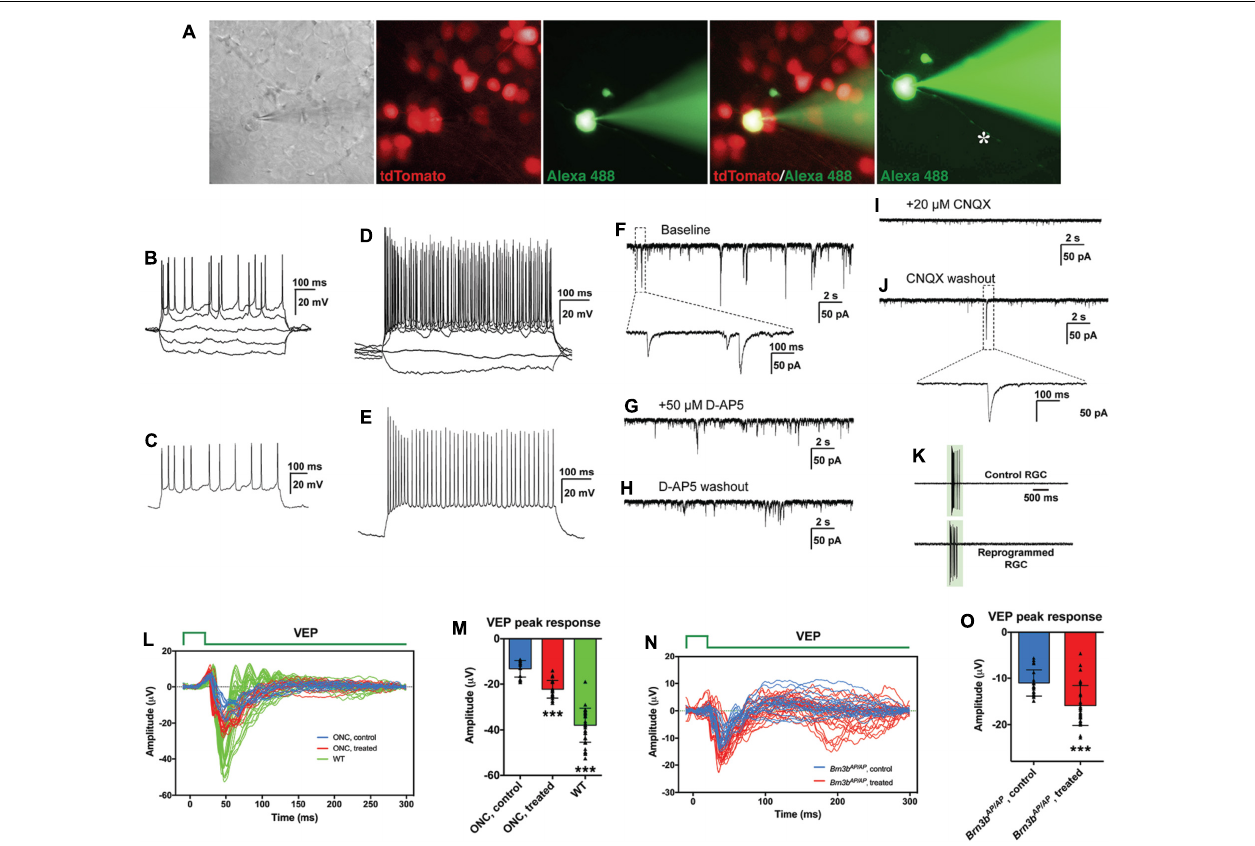
FIGURE 7 | MG-derived RGCs improve visual function of RGC loss mouse models. (A–J) Patch-clamp recordings of reprogrammed RGCs in mouse retinas at 3 weeks after treatment with GFAP-Math5-Brn3b-tdTomato AAVs. (A) An MG-derived RGC marked by tdTomato (red) was chosen for patch-clamp recording. Alexa Fluor 488 hydrazide was used to confirm the recorded cell and visualize the axon (indicated by the asterisk). (B,D) Current-clamp recordings revealed action potential responses of the MG-derived RGCs under current injection. (C,E) Action potentials were induced after depolarization of the patched cells. (F–J) Representative traces of spontaneous excitatory postsynaptic currents (sEPSCs) of an MG-derived RGC. Voltage clamp was performed and responses were recorded under baseline condition (F) , D-AP5 application (G) , D-AP5 washout (H) , CNQX application (I) , and CNQX washout (J) . (K) Light-evoked spikes of control and reprogrammed RGCs were obtained with current-clamp recording. The duration of light stimulus is indicated by the green rectangle. (L,M) Visual evoked responses (VEPs) to a flash light in the visual cortex of ONC mouse models in right eyes (WT, without optic nerve crush, n = 7) and in left eyes (optic nerve crushed) treated with GFAP-Math5-Brn3b-GFP AAVs (ONC, treated, n = 4) or GFAP-GFP AAVs (ONC, control, n = 3). VEP recordings were performed at 6 weeks after AAV treatment. Shown in (L) are responses from all trials and five trials were performed for each eye. Shown in (M) are amplitudes of the VEP response peaks for control, treated and WT eye groups. Points represent single trials. Data are presented as mean ± SD. Asterisks indicate significance in one-way ANOVA test with Bonferroni’s correction: *** p < 0.0001. (N,O) VEPs to a flash light in the visual cortex of Brn3b AP / AP mice treated with GFAP-Math5-Brn3b-tdTomato AAVs ( Brn3b AP / AP , treated, n = 6 eyes) or GFAP-tdTomato AAVs ( Brn3b AP / AP , control, n = 4 eyes). VEP recordings were performed at 4 weeks after AAV treatment. Shown in (N) are responses from all trials. Shown in (O) are amplitudes of the positive VEP response peaks for control and treated eye groups. Points represent single trials. Data are presented as mean ± SD. Asterisks indicate significance in unpaired two-tailed Student’s t -test: *** p <